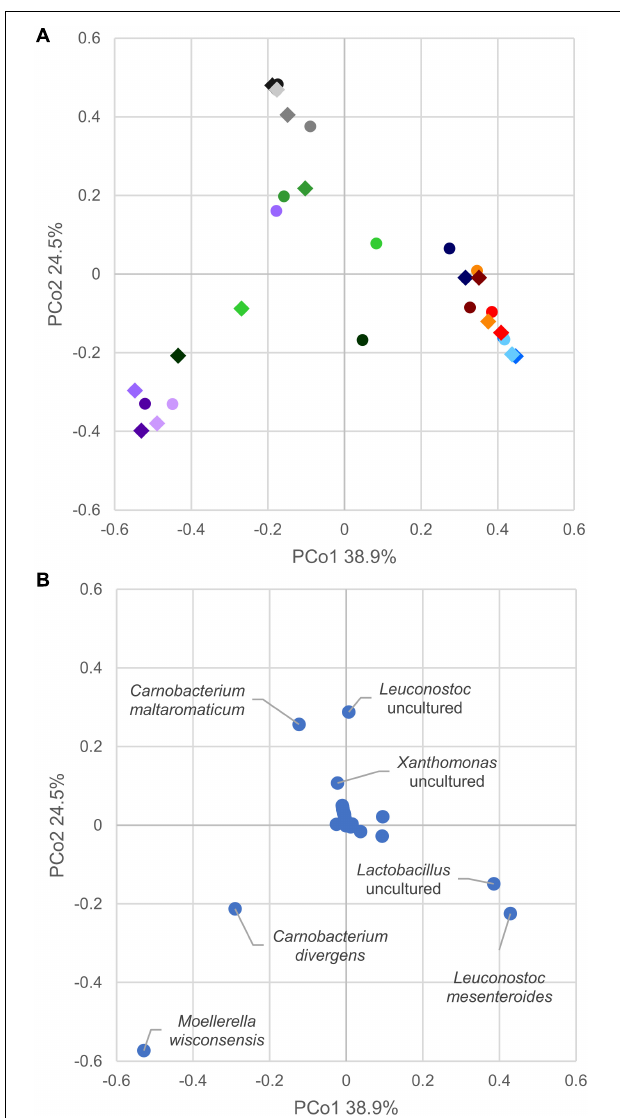
FIGURE 4 | (A) Principal coordinate analysis plot of beta diversity based on Bray–Curtis dissimilarity index of cooked ham microbiome. Different colors indicate products, A (blue), B (violet), C (green), D (red), and E (gray). Circles mark samples at opening, diamond after 8 days. (B) Principal coordinate analysis plot of species contribution to sample differentiation.